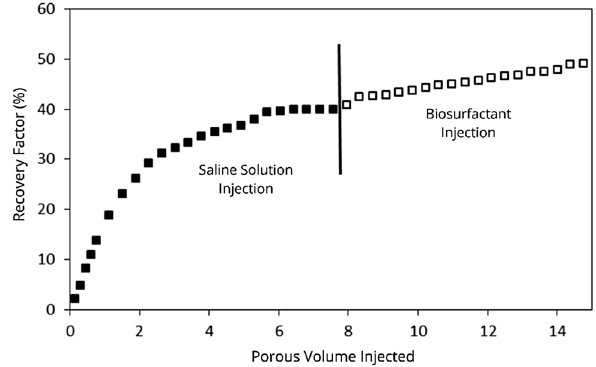
Fig. 6 Recovery factor as a function of porous volume injected for biosurfactant solution 100% above CMC after 2 months of Table 1 Resume of the recovery Rhamnolipid concentration Petroleum Conventional recov- factors for the MEOR trials ery factor (%)